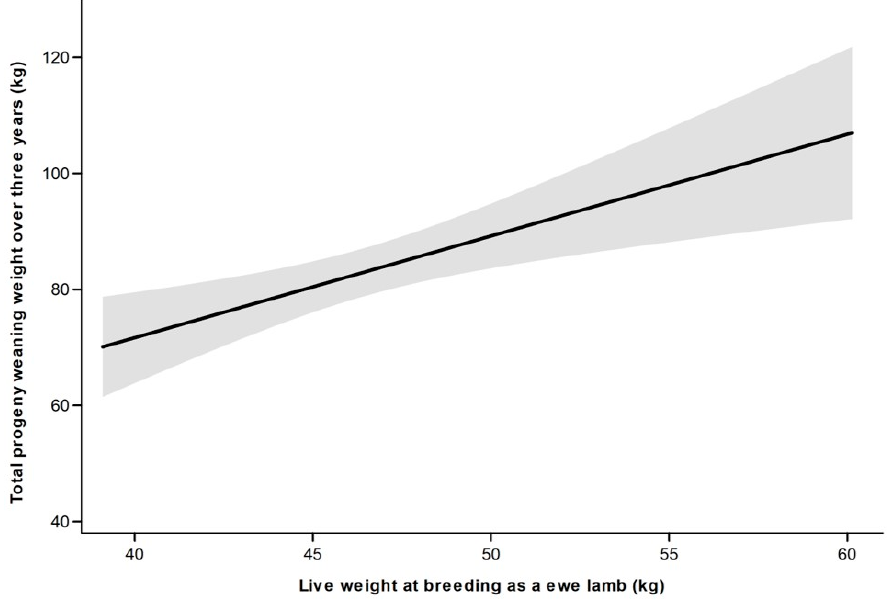
Figure 3. Total progeny weaning weight (kg) over the first three years of production in relation to ewe lamb live weight at breeding (d213). Predictions and 95% confidence intervals shown (r 2 = 0.044).